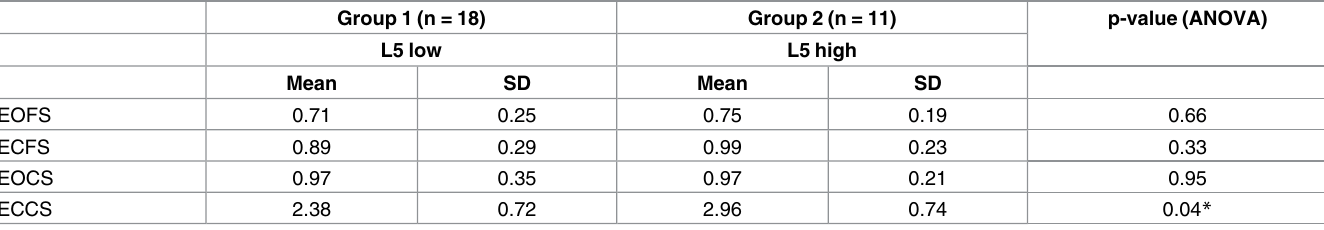
Table 4. Sway index of Sensory Organization Test (Static